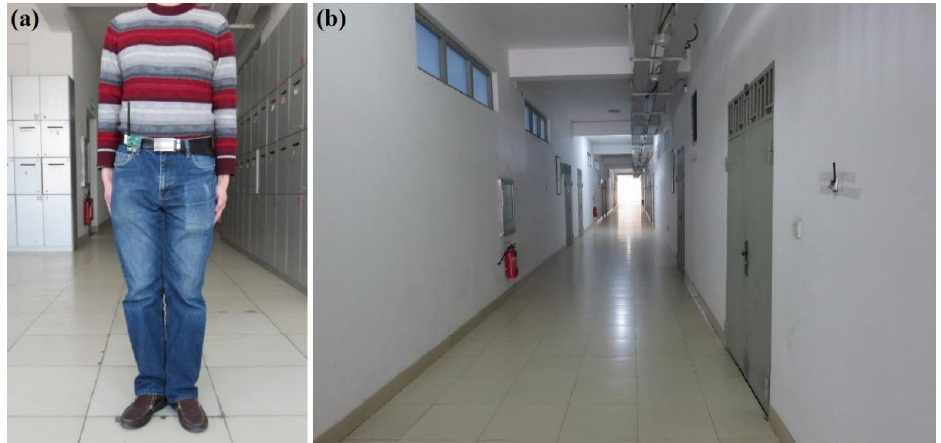
Figure 13. ( a ) Illustration of the blind target; ( b ) Illustration of testing scenario 1.